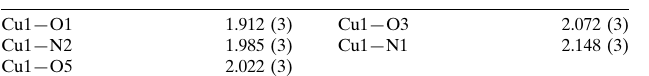
Selected bond lengths (A˚ ).